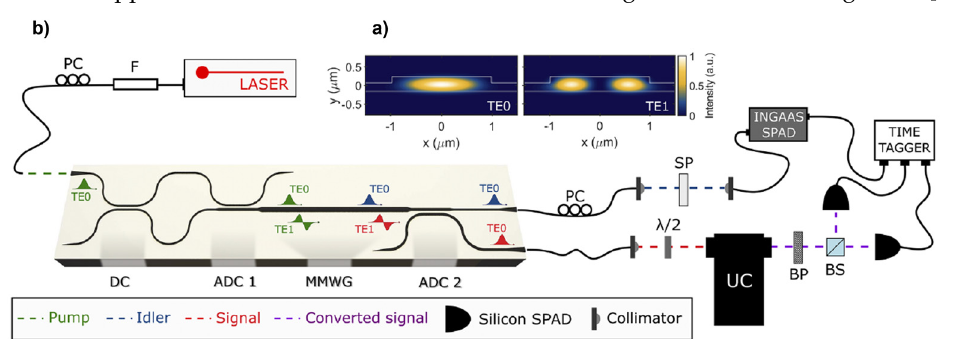
Figure 17. ( a ) Simulation of the TE0 and TE1 modes intensity profiles in the multimode waveguide (MMWG). ( b ) Schematic of the experimental setup. The pump is a pulsed laser at 1550.3 nm coupled to the chip using a tapered lensed fiber. In the chip after a 3-dB directional coupler (DC), an asymmetric directional coupler (ADC1) is used to convert half of the pump to the TE1 mode, leaving the other half on the TE0, allowing the pump to reach the multimode waveguide equally split in the two modes. The inter-modal SFWM process takes place in the waveguide, with the generation of the idler photon (blue) in the TE0 mode and the signal (red) photon in the TE1 mode. A second asymmetric directional coupler (ADC2) is used to convert the signal to the TE0, in order to easily separate the idler and signal photons, which are finally out-coupled from the chip with two tapered lensed fibers. The idler photons are detected via an InGaAs SPAD, after being filtered with a short pass filter (SP) with a cut-off wavelength of 1335 nm to suppress the pump residual and Raman noise. The signal photons are upconverted to the visible through an upconverter (UC) system and analyzed by an HBT interferometer. Reproduced with permission from [74], copyright 2021.